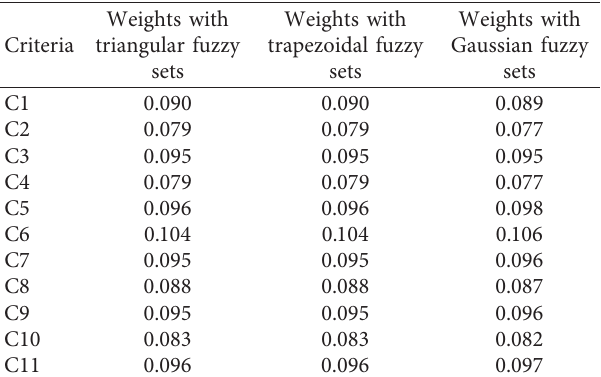
Table 20: Comparative analysis